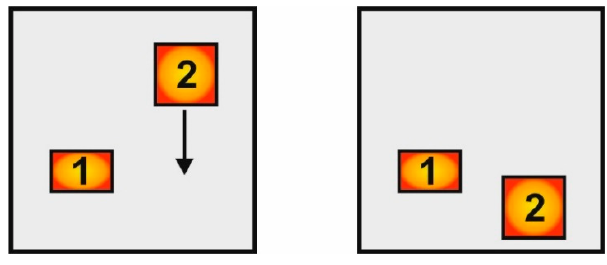
Figure 4. Sketch of a non-Manhattan transformation for a multi-source die.